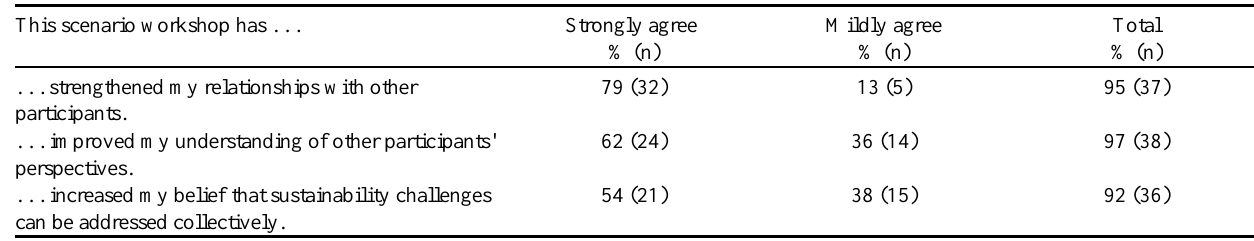
Table 1 . Relationships and appreciation of others' perspectives. Percentage of participants who 'strongly agree' (5 on 1 to 5 scale) and 'mildly agree' (4 on 1 to 5 scale) with the following survey statements (n = 39 surveys), and the total number who agree (either 4 or 5 on 1 to 5